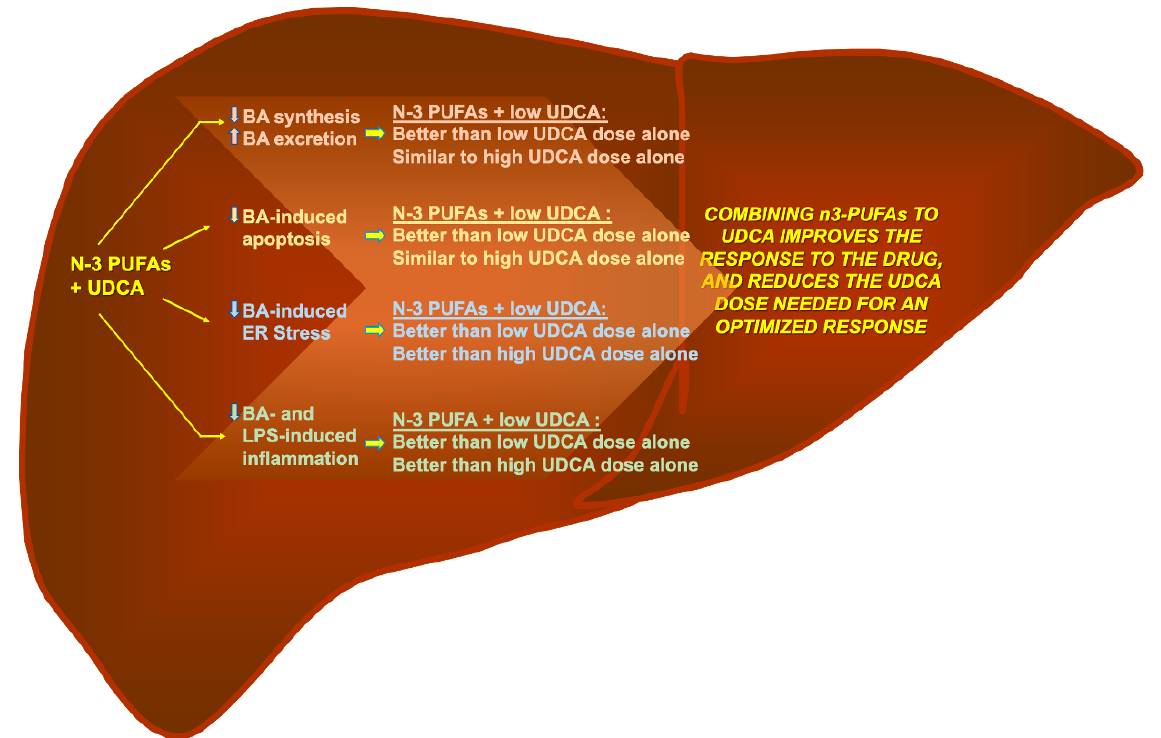
Figure 6. Omega-3 polyunsaturated fatty acid: a pharmaco-nutraceutical approach to improve the responsiveness to ursodeoxycholic acid. Results from the present study indicate that n-3 polyunsaturated fatty acids (n-3 PUFAs), such as EPA and DHA, improve the response of low UDCA dosage with regards to the reduction of BA toxicity, the prevention of BA-induced apoptosis and ER-stress, as well as the reduction of BA- or LPS-induced inflammation. These data support the idea that combining n-3 PUFAs with UDCA improves the response to the drug and reduces the UDCA dose required for an optimized response.